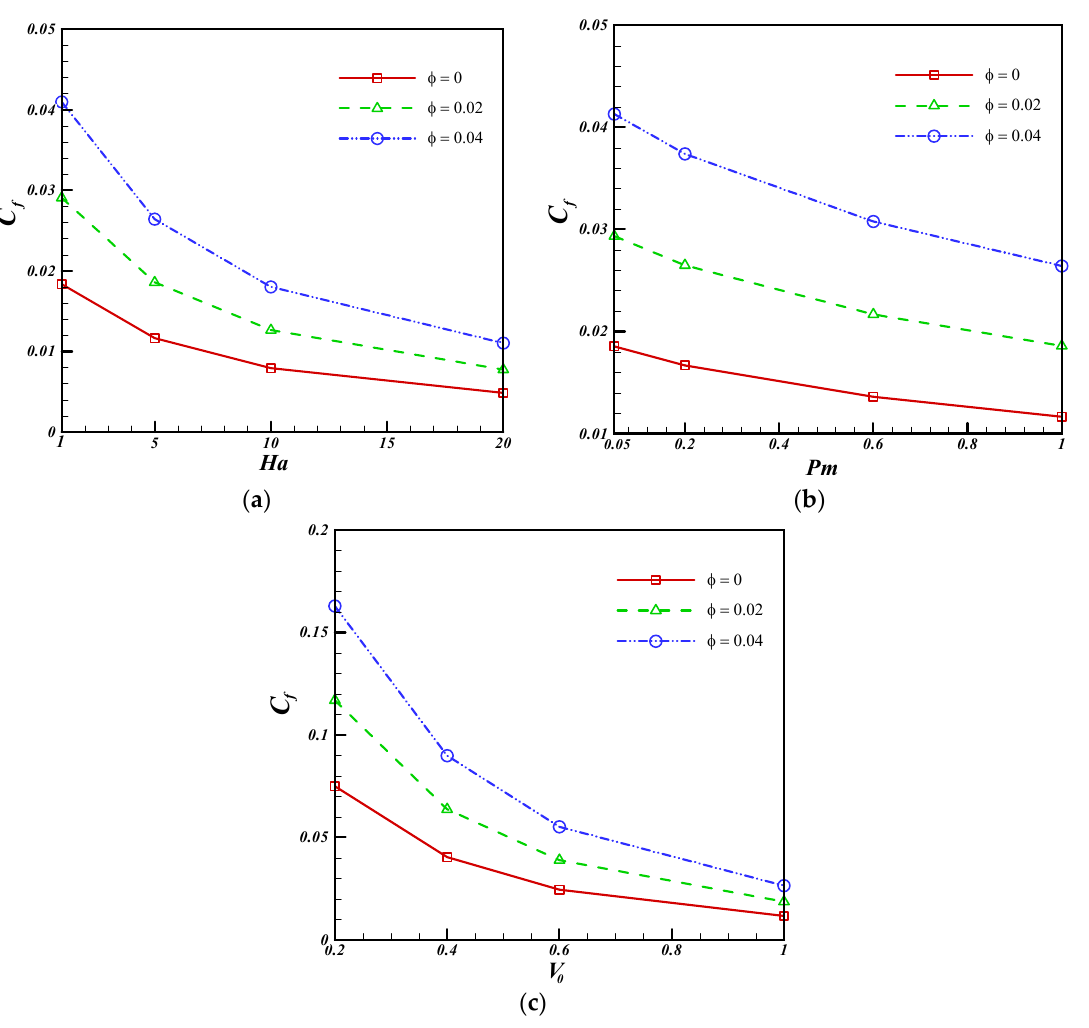
Figure 6. Influences of magnetic Prandtl number ( Pm ) , Hartmann number ( Ha ) , suction parameter ( V ) and nanoparticle volume fraction ( φ ) on skin friction coefficient 0 ( a ) V 0 = 1, Pm = 1; ( b ) V 0 = 1, Ha = 5; ( c ) Ha = 5, Pm =